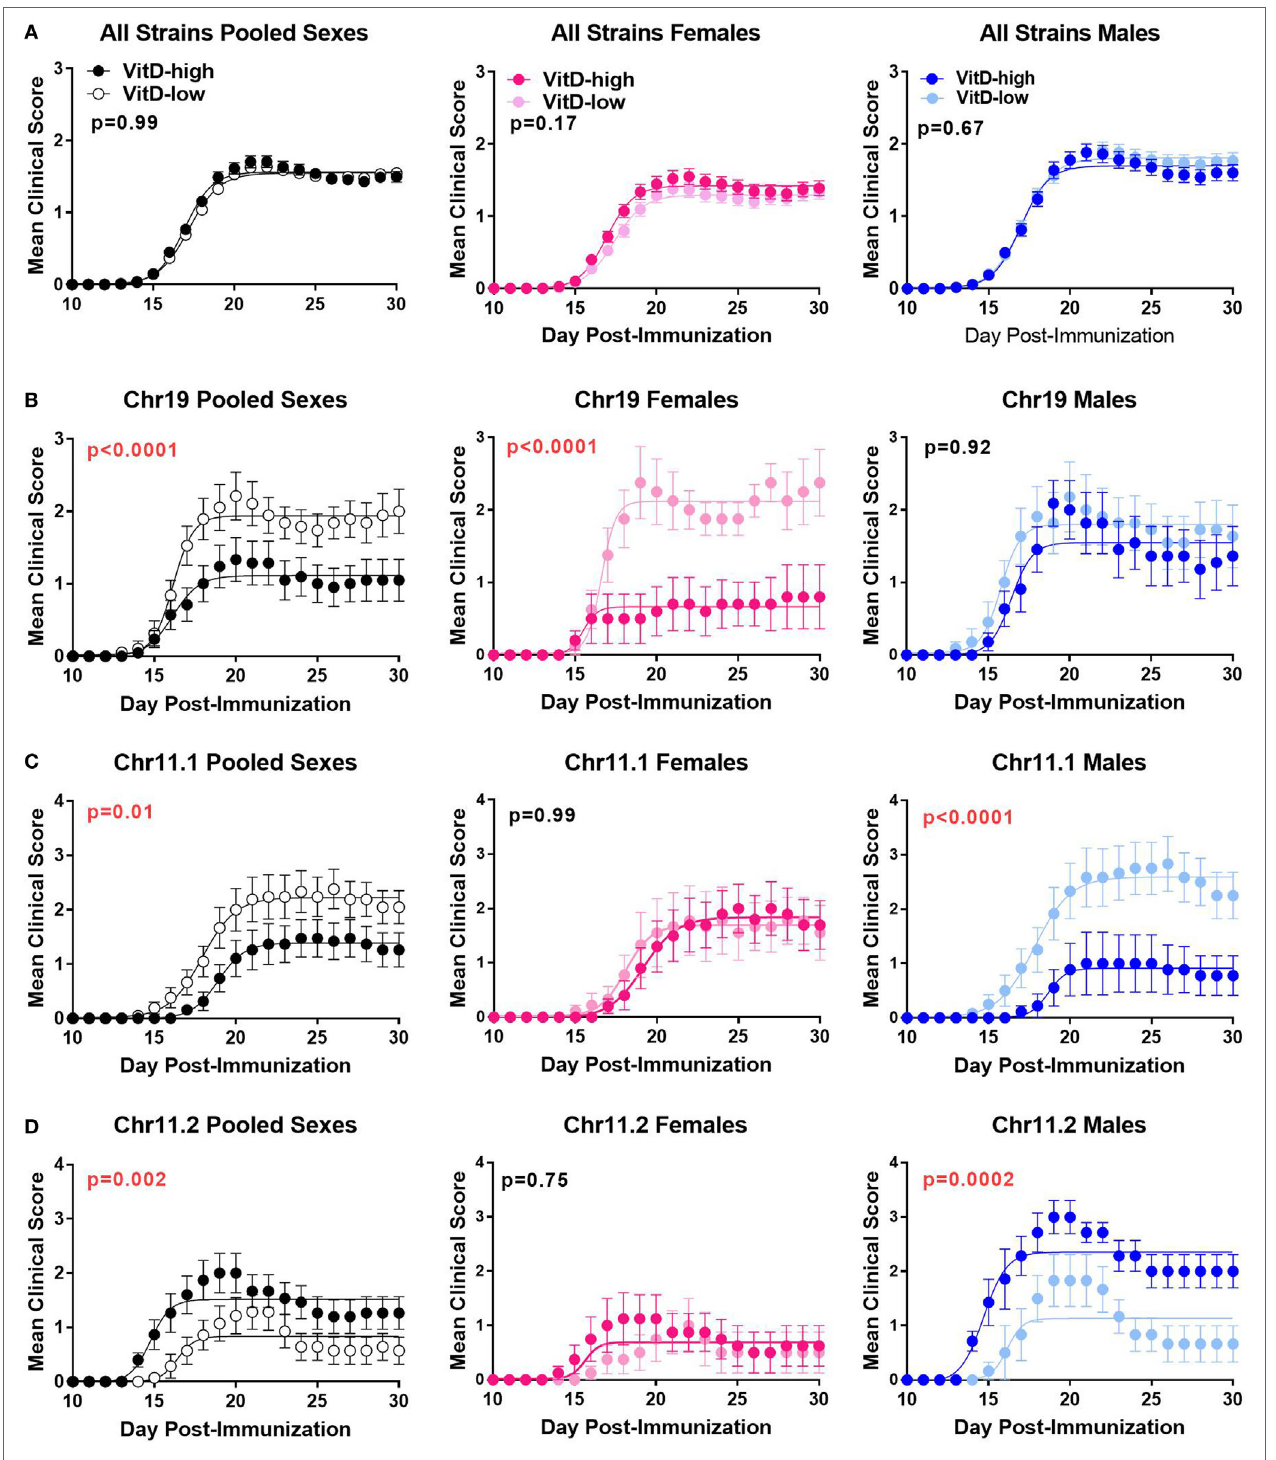
FigUre 4 | Effects of vitamin D3 (VitD) on EAE disease course in B6.Chr PWD consomic mice. B6.Chr PWD consomic mice were exposed to VitD-high and VitD-low diets, as in Figure 2 , followed by induction of EAE. Disease course in a pooled analysis of all consomic strains (a) , or in three representative consomic strains, Chr19 PWD (B) , Chr11.1 PWD (c) , and Chr11.2 PWD (D) , is shown for pooled sexes, or for each sex separately, as indicated. p -Values for the effect of diet on overall EAE course (representing the interaction term for treatment × time, repeated measures two-way ANOVA) are shown. Numbers of animals per group are shown in Table S1 in Supplementary